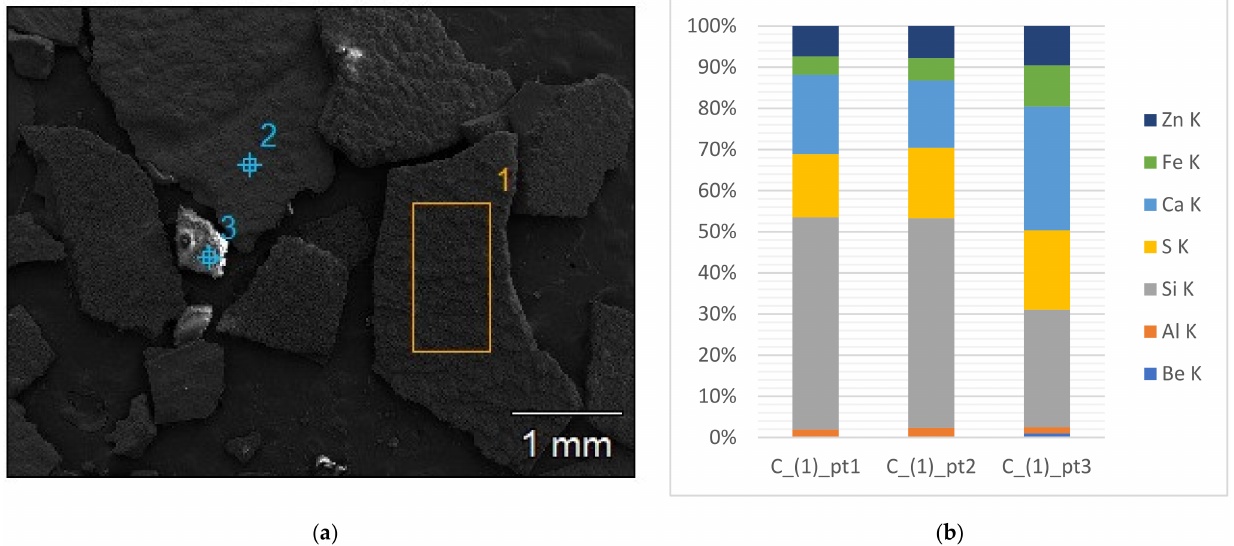
Figure 6. ( a ) SEM morphological characteristics at points (1, 2, 3) of deposit (piston, landfill C); ( b ) quantitative SEM-EDS microanalysis of the chemical composition of extreme layers of deposits sampled from the piston (landfill C), mass fraction